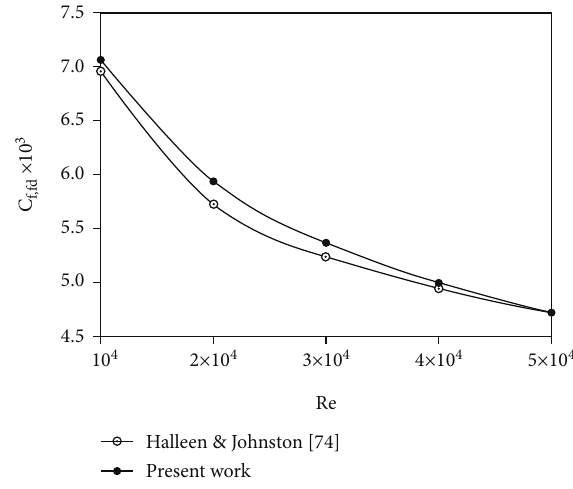
Figure 2: Comparison of skin friction found in the present study with the relationship found by Halleen et al. [74]. Table 3: Comparison between Nusselt numbers found in the present work and those of Hatton and Quarmby